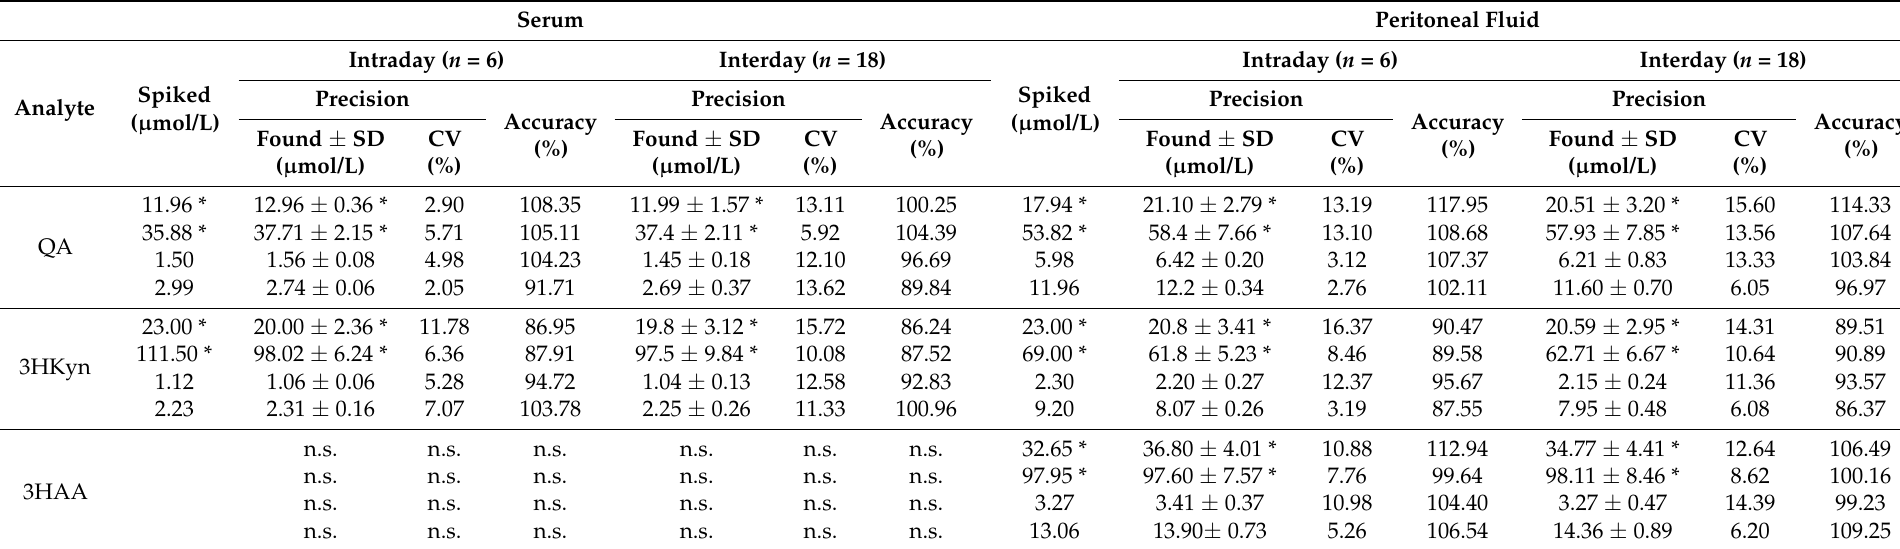
Table 3. Precision and accuracy of the